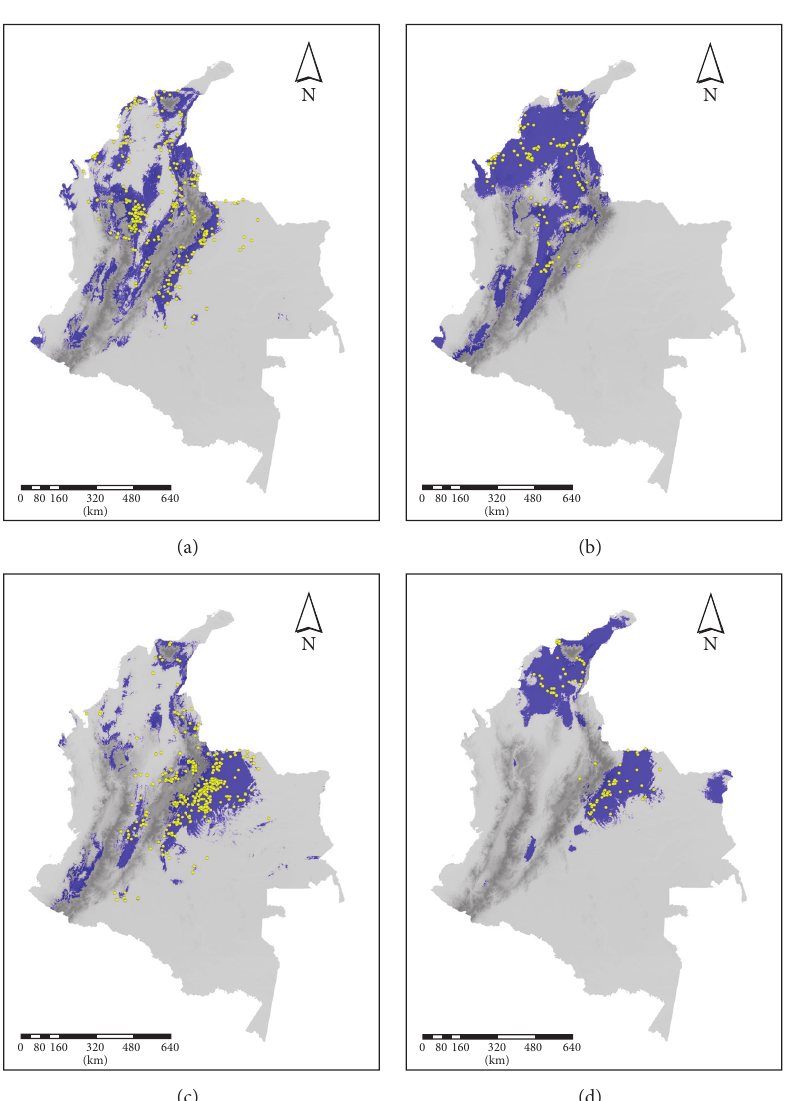
Figure 3: Distributional models of representative Triatominae species from Colombia: (a) Panstrongylus geniculatus ; (b) Rhodnius pallescens ; (c) Rhodnius prolixus ; (d) Triatoma maculata . The areas identified as suitable based on climatic information are shown in blue. The yellow points indicate the occurrence data for each species. Dark and light gray represent areas not predicted for the